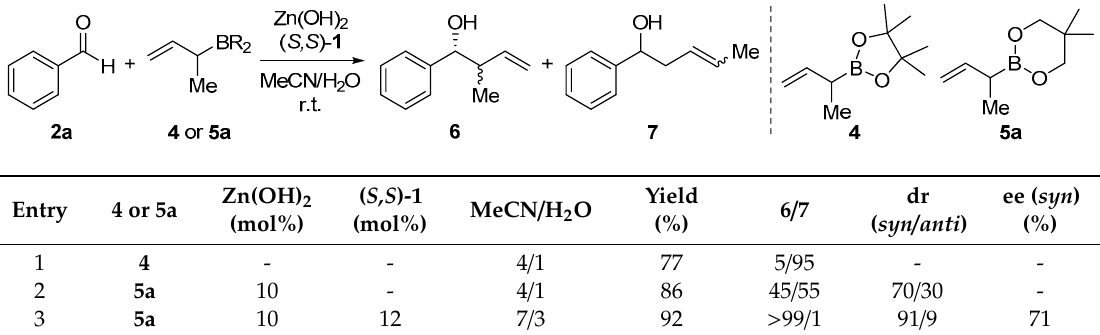
Table 1. Allylation of benzaldehyde 2a .